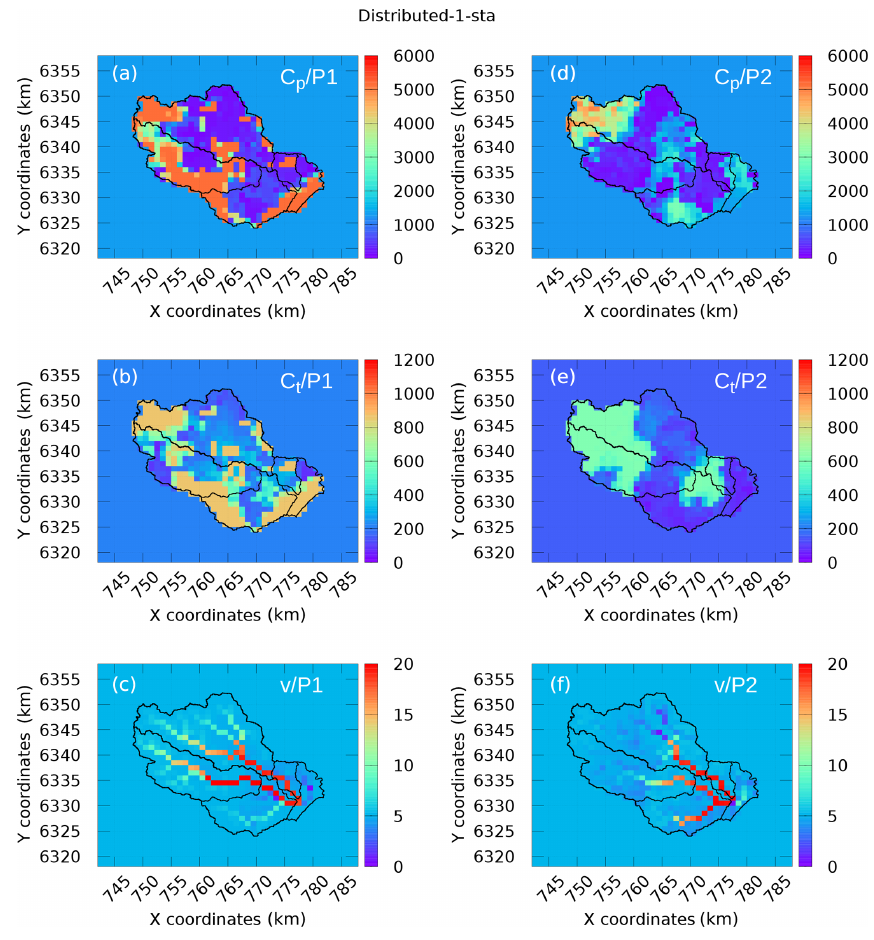
Figure 7. Maps of the calibrated coefficients (experiment 3 and 1-sta): (a–c) data from P 1 and (d–f) data from P 2.